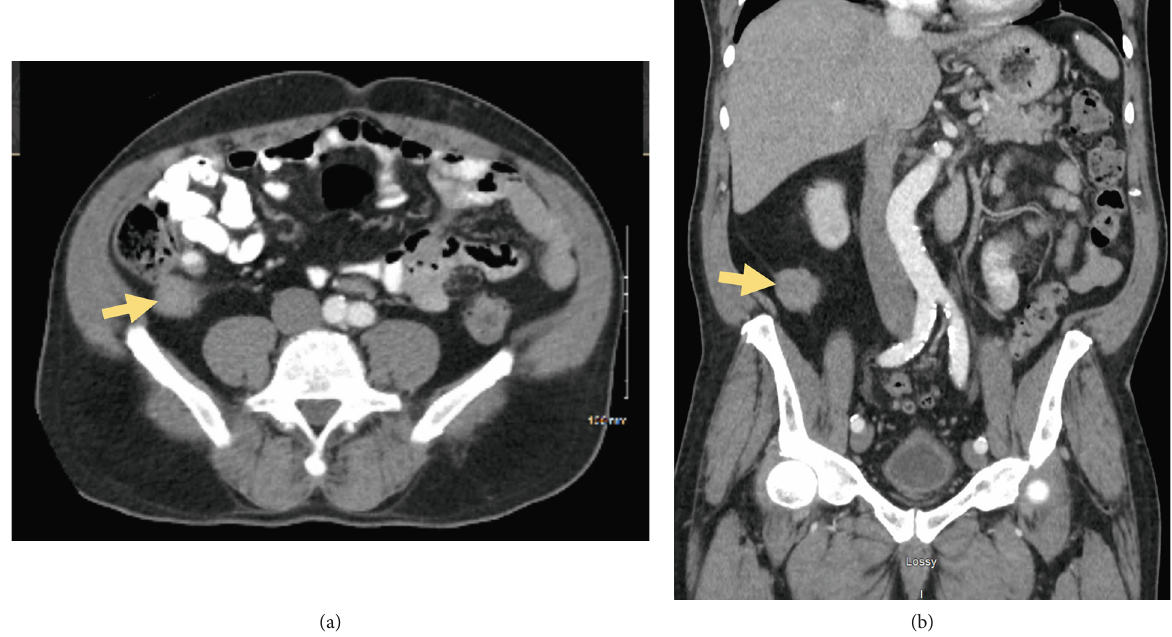
Figure 1: (a) Axial abdomen/pelvis CT showing a soft tissue mass (arrow) at the tip of the appendix. (b) Coronal image of the soft tissue mass (arrow) at the tip of the appendix.